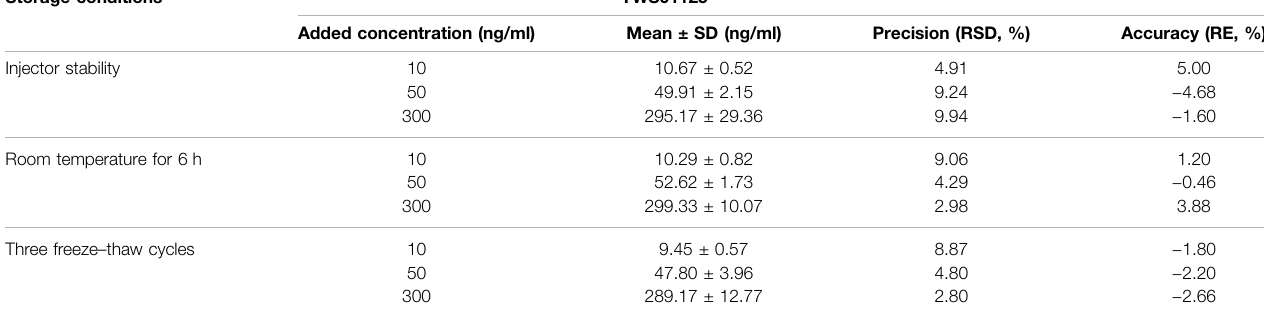
TABLE 3 | Stabilities of YWS01125 in the mouse plasma (n = 6). Storage conditions